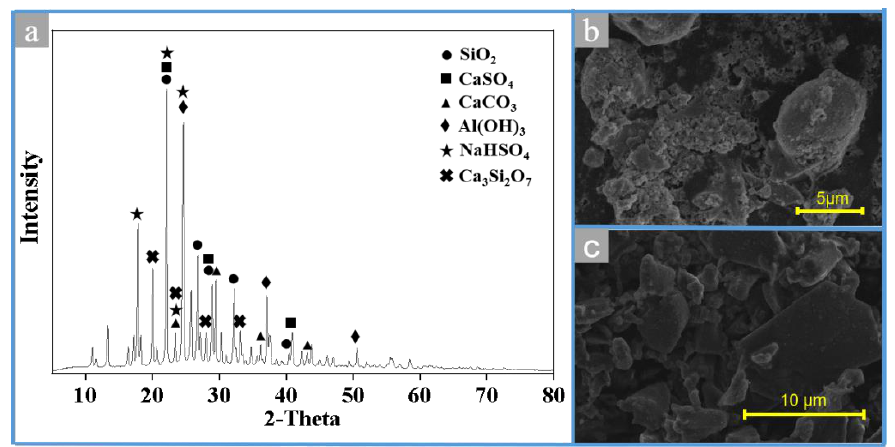
Figure 9. XRD patterns ( a ) and SEM images ( b ) and ( c ) of treated MSWI fly ash.